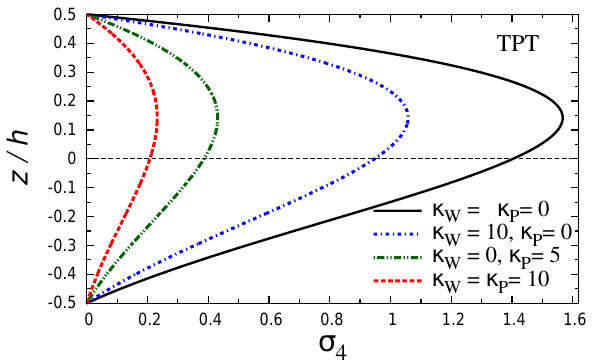
Figure 8: Through-the-thickness distributions of transverse shear stress σ 4 of the EG thick rectangular plate on elastic foundations ( a = 4 h , b = 3 a , k = 1.5) .